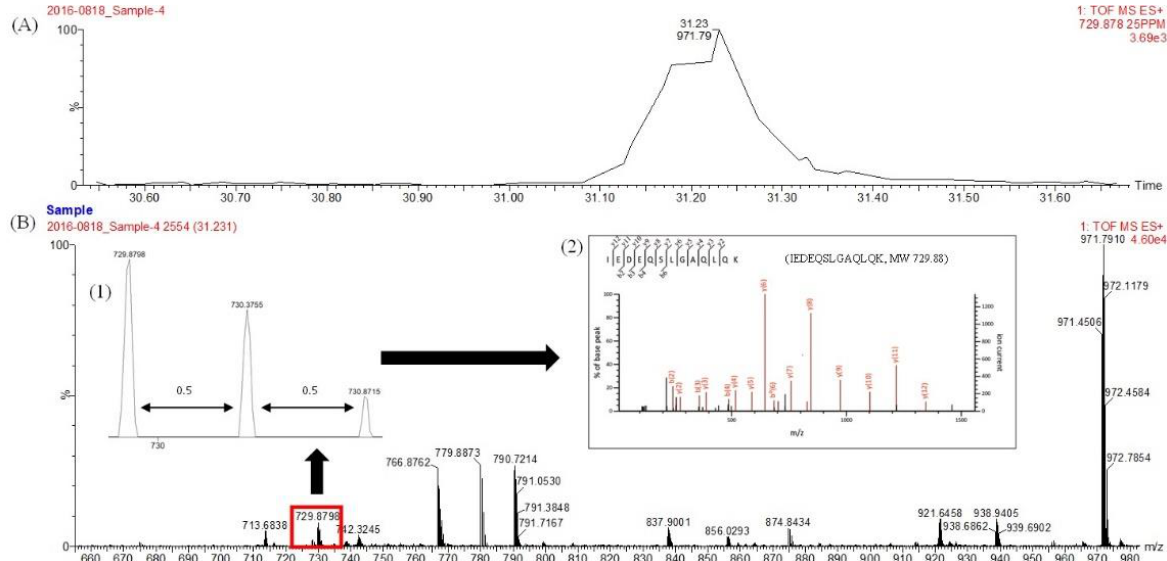
Figure 2 . ( A ) LC-MS/MS chromatogram of tryptic peptides identified from MSJ protein band A4 (Figure 1) at 31.24 min. ( B ) The representative spectrum of LC-MS/MS with doubly charged signal (1) and fragmentation spectrum (2) .